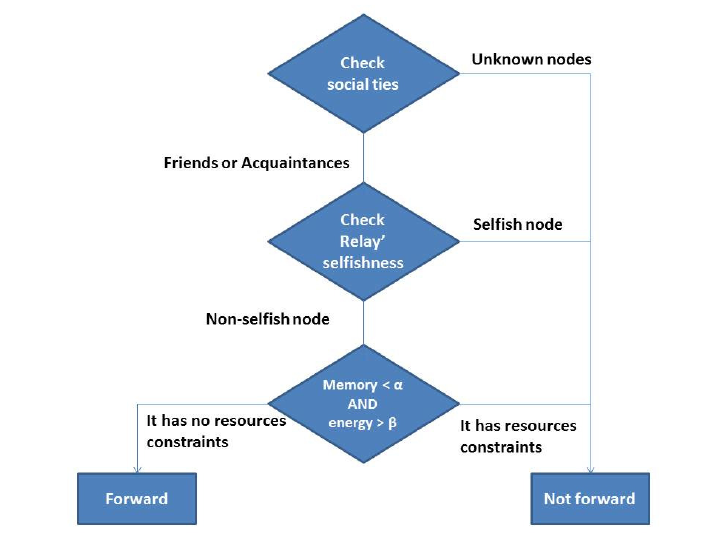
Figure 1. Flowchart of the FSF forwarding